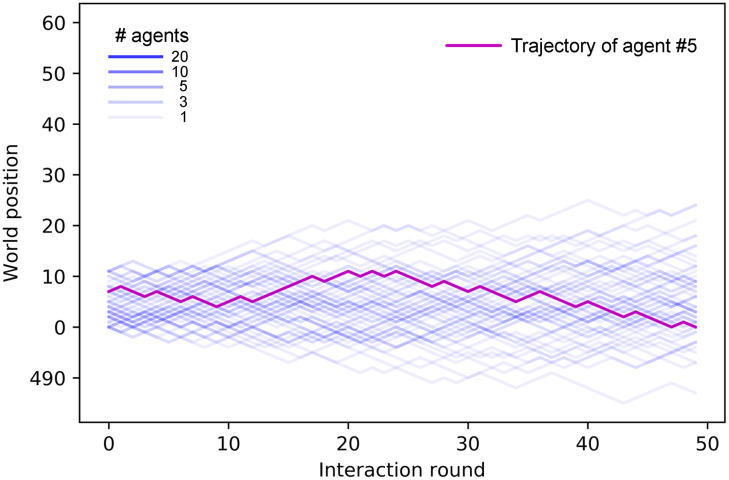
Trajectories (position vs. time) of an ensemble of 60 agents in one trial prior to any learning process.The vertical axis displays the position of the agent in the world and the horizontal axis the interaction round (note that the trial consists of n = 50 rounds). Each line corresponds to the trajectory of one agent. However, some agents’ trajectories overlap, which is indicated by the color intensity. The trajectory of one particular agent is highlighted for clarity.